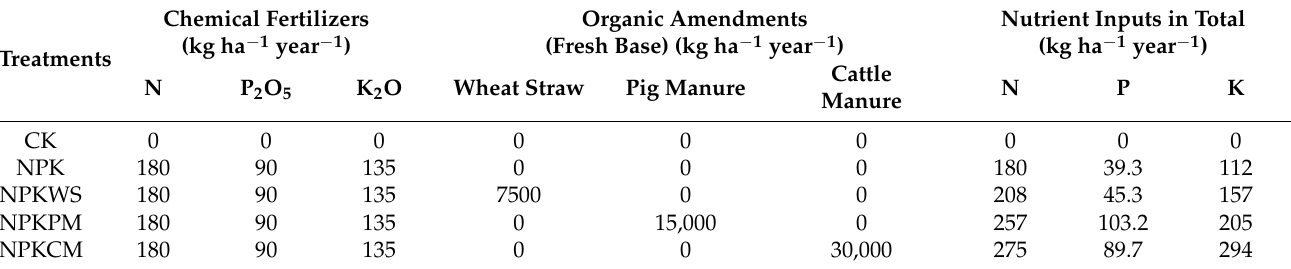
Table 1. Fertilizer application rates in each